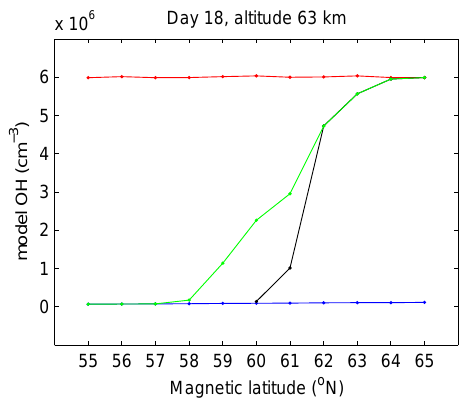
Fig. 7. Model OH at 63km on 18 January, the CTR (blue), CUT (black, K p saturated at 6), and SPE (red) run results are shown at different magnetic latitudes. The green line shows the CUT run results when K p is not forced to values ≤